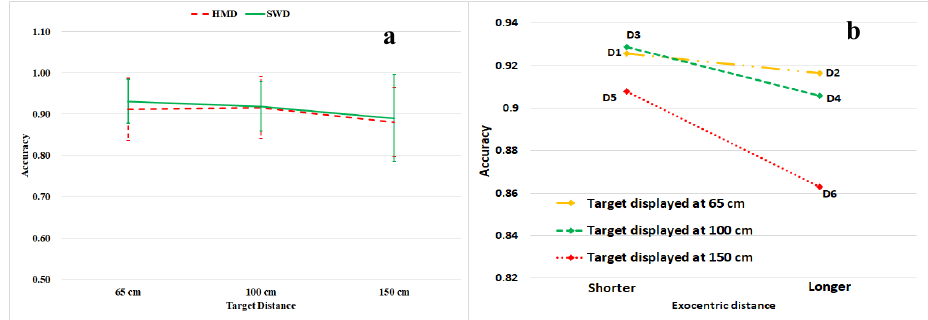
Figure 6. The main e ff ect of ( a ) target distance and ( b ) size on vertical position accuracy. It shows that the overall vertical position estimates were worsened as both target distance and exocentric distance